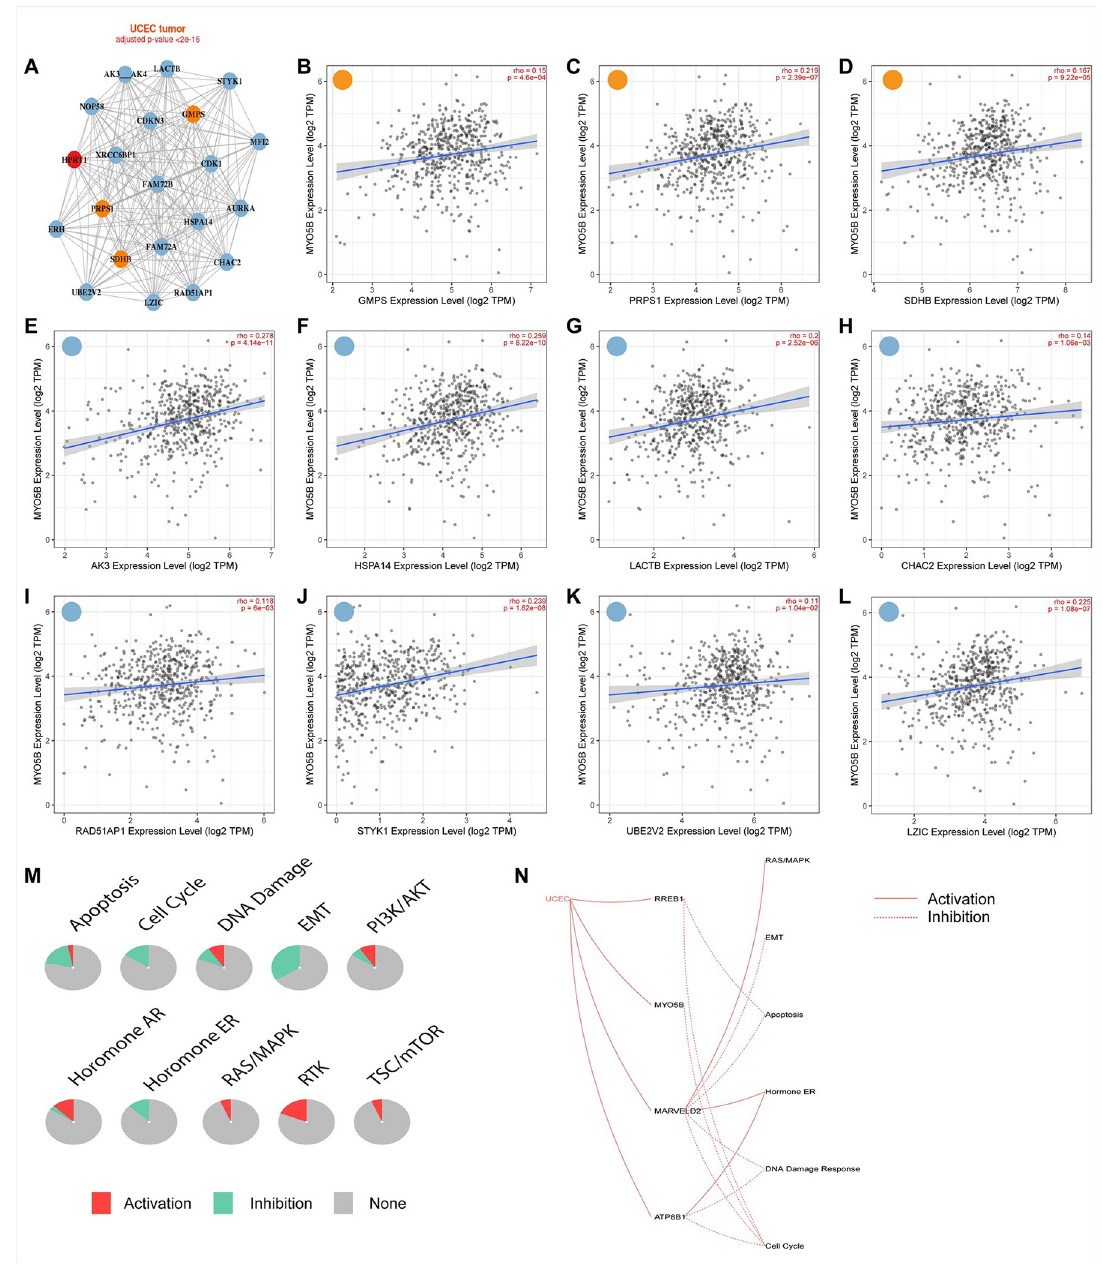
Fig 7. MYO5B mRNA positively correlated with several metabolism related genes and cell cycle in UCEC patients. A. Visualization of a metabolic pathway in UCEC patients with HPRT1 (red dot) as the inserted gene. Metabolism genes are visualized as orange dots and associated genes are visualized as blue dots. MYO5B was found to correlate with metabolism genes B. GMPS; C. PRPS1; and D. SDHB. Positive correlations with MYO5B were also observed with other genes including E. AK3; F. HSPA14; G. LACTB; H. RAD51AP1; J. STYK1; I. UBE2V2 and L. LZIC. M. Pathway Activity module of the top genes positively correlated with MYO5B mRNA expression in UCEC tumors. The pathway activity module presents the difference of genes expression between pathway activity groups (activation (red) and inhibition (green)) based on pathway scores. The pie graphs represent the global percentage of cancers in which a gene has an effect on the pathway among 32 cancer types. N. Relationship network based on the top genes positively correlated with MYO5B mRNA expression in UCEC tumors. The network indicates the relationship between genes and pathways by a line connection. Solid line indicates activation, dashed line indicates inhibition.